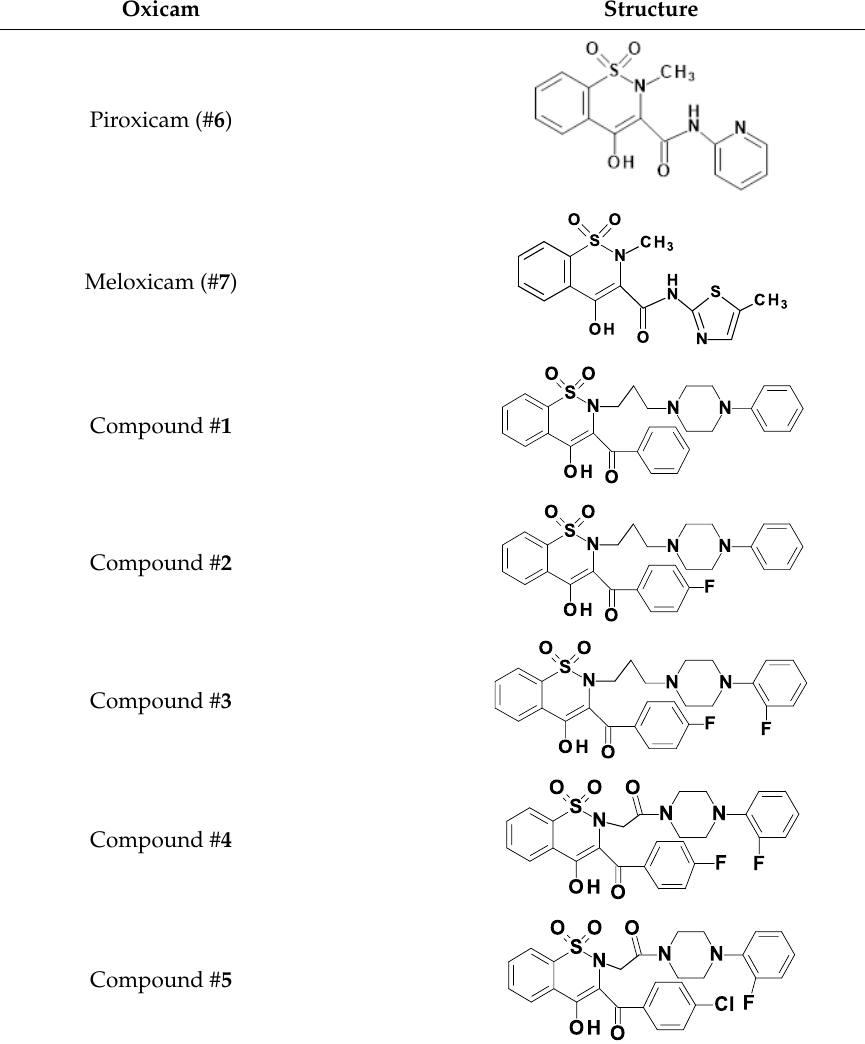
Table 4. Structures of the examined Table 4. Structures of the examined oxicams. Table 4. Structures of the examined oxicams. Table 4. Structures of the examined oxicams. Table 4. Structures of the examined oxicams. Table 4. Structures of the examined oxicams. Table 4. Structures of the examined oxicams. Table 4. Structures of the examined oxicams.